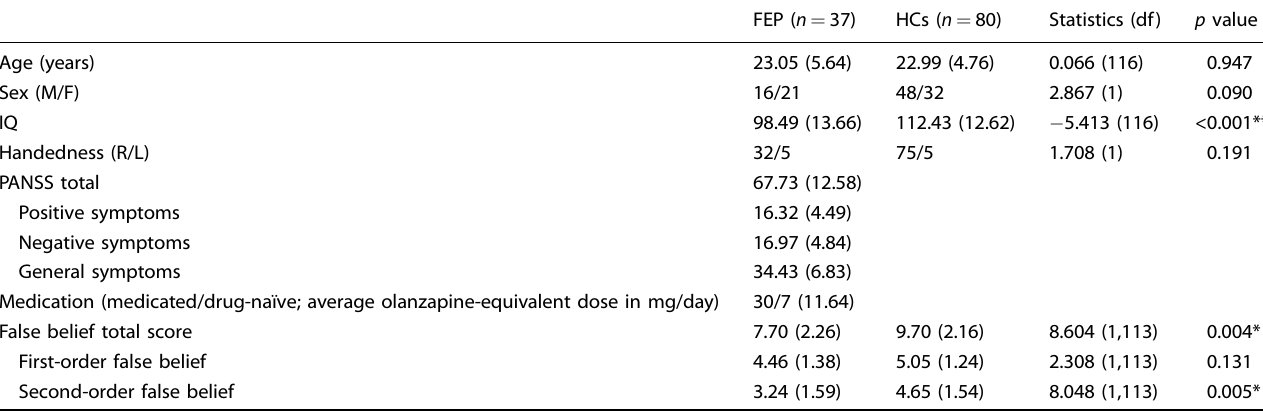
Table 1. Sociodemographic, clinical, and theory of mind (ToM) task performance characteristics of